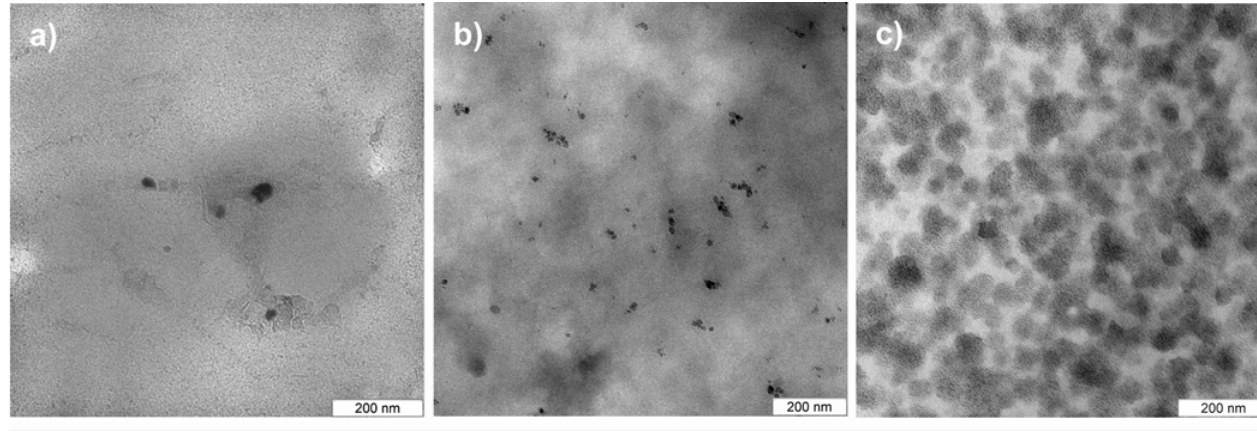
Figure 3. TEM images of MNP distribution in a) film 5, b) film 6, and c) film 7. Sections are longitudinal thin sections, that is, sections in the plane of the